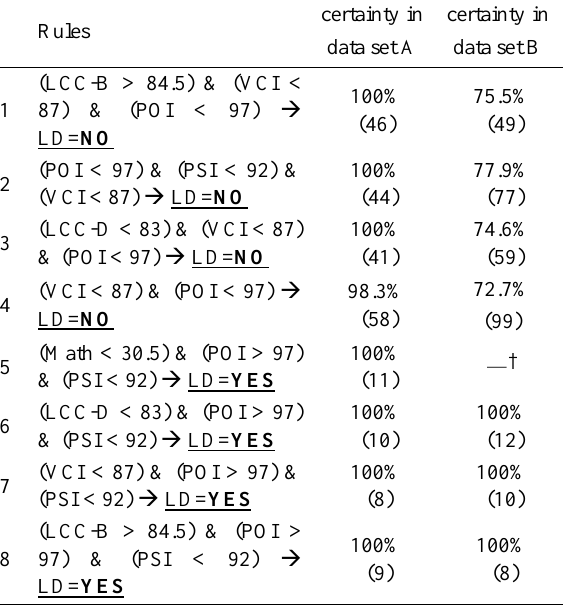
Table 8. Rules extracted from experiment 1 using data set A, with each rule being the one that receives the top-four most support within its class. (The number within parenthesis represents the support when applying the rule to the specific data